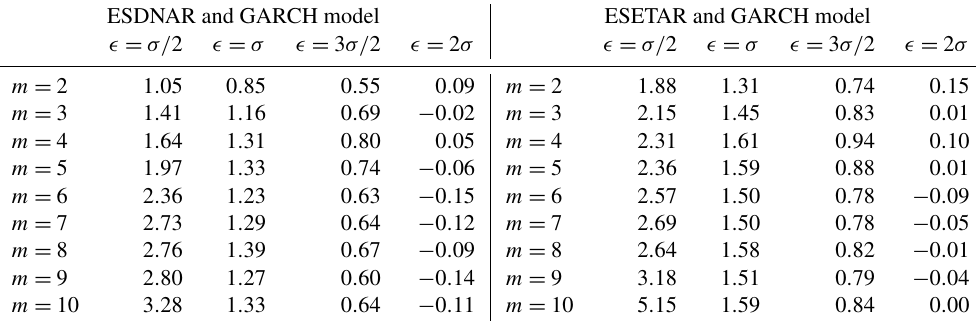
Figure 8. Properties of the ESETAR (a–c) , ESDNAR and generalized autoregressive conditional heteroskedasticity (GARCH) (d–f) and ESETAR model with GARCH noise (g–i) models for the daily NAO winter index. The plots are generated in the same way as the plots in Fig. 4. Table 5. BDS test results for the standardized residuals of the GARCH noise models. The test has been performed with parameter values m ∈ { 2 ,..., 10 } and (cid:15) ∈ { 1 / 2 , 1 , 3 / 2 , 2 } σ , where σ is the sample standard deviation of the residuals. Note: “ESDNAR and GARCH” denotes the ESDNAR model with GARCH noise, and “ESETAR and GARCH” denotes the ESETAR model with GARCH noise. ESDNAR and GARCH model ESETAR and GARCH